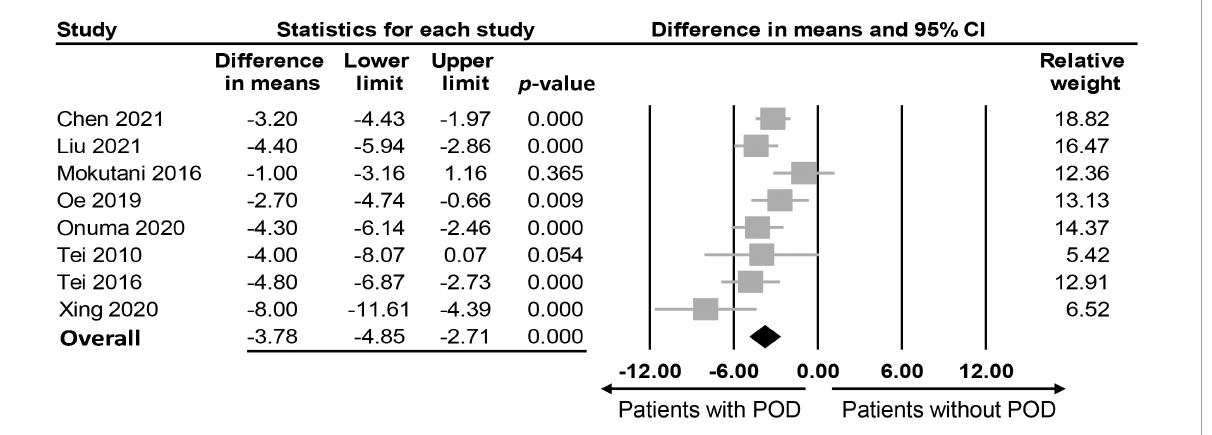
FIGURE3 Forest plot comparing values of prognostic nutritional index (PNI) between postoperative delirium (POD) and non-POD groups, showing a lower PNI in the POD group compared to the non-POD group (MD: –3.78, 95% CI: –4.85 to –2.71, p < 0.0001, I 2 = 54.2%). CI, confidence interval.